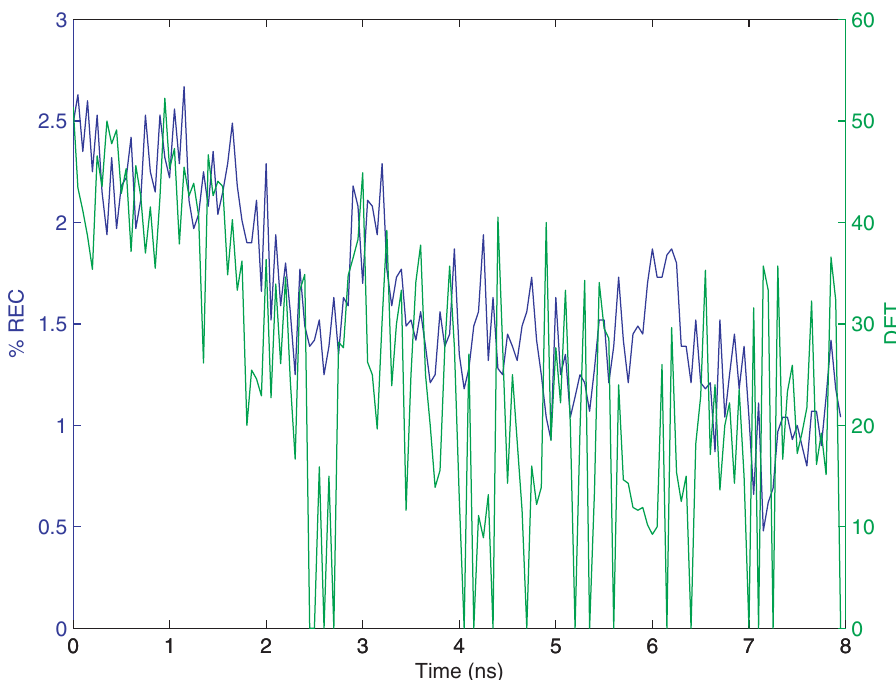
Figure 6. REC and DET over Unfolding.